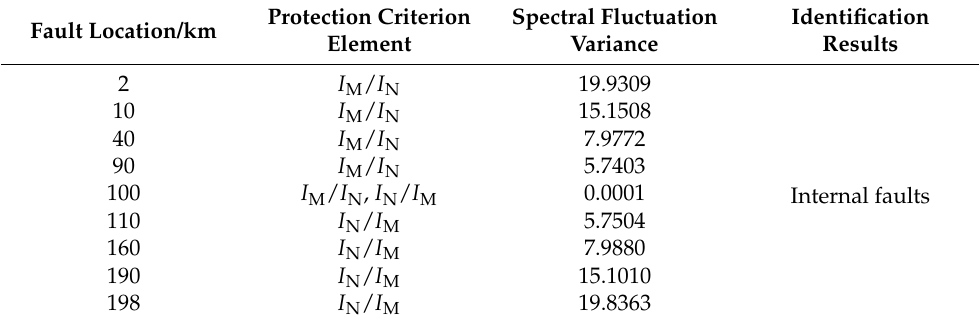
Table 1. Spectrum fluctuation variance in the fault current ratio at different fault locations during the internal A-phase ground fault.